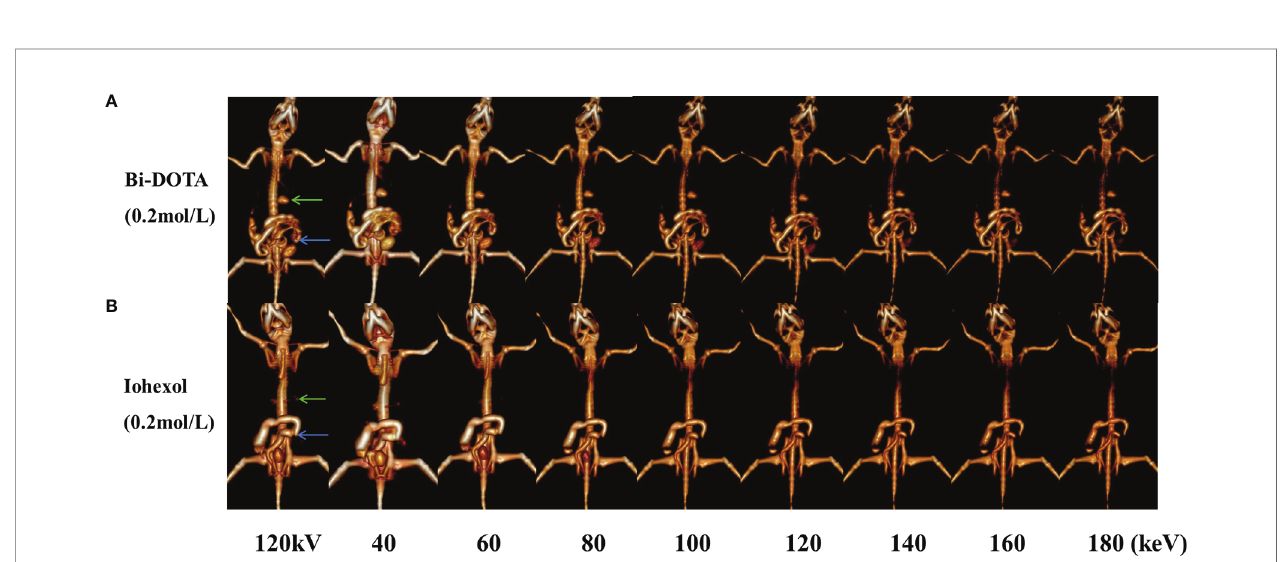
FIGURE 7 | In vivo spectral GI tract CT imaging under different energies using 0.2 mol/L Bi-DOTA (A) and iohexol (B) (green arrows represent stomach and blue arrows represent small intestine).